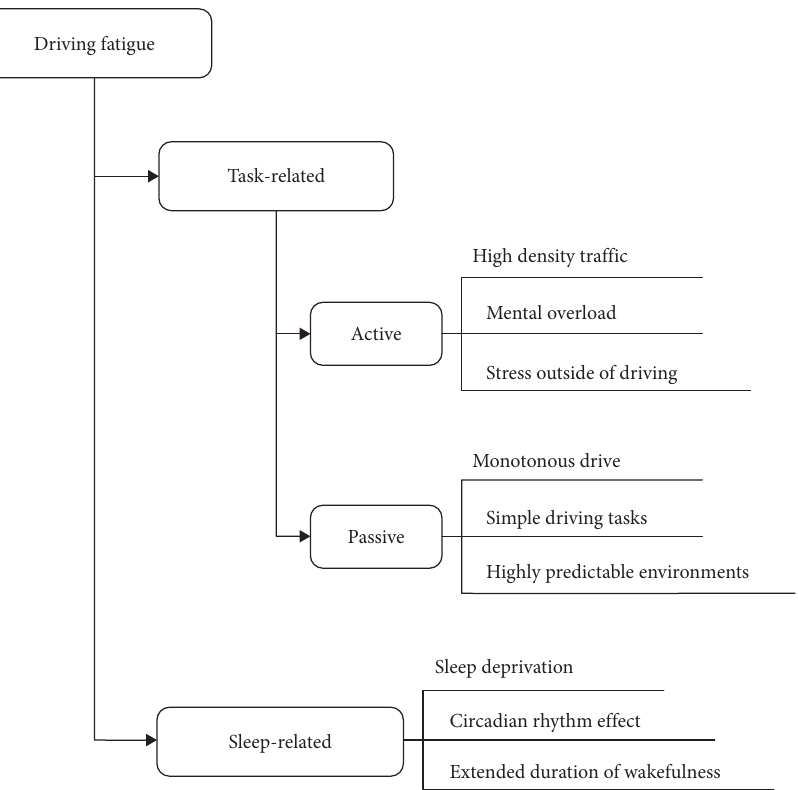
Figure 1: Predisposing factors of driving